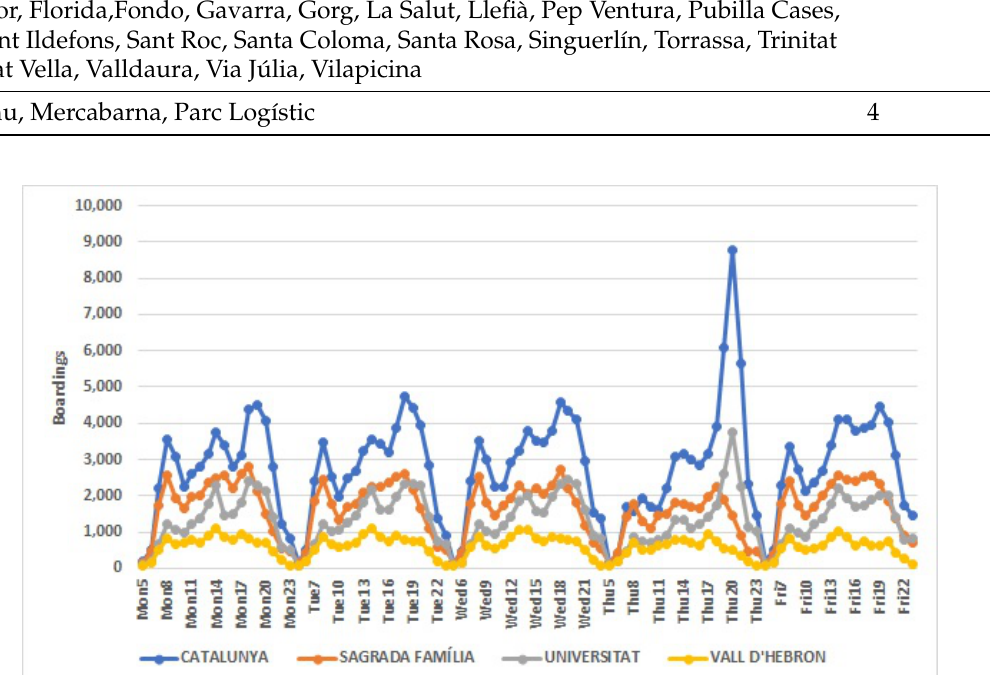
Figure 13. Pattern of boardings in stations of Cluster 1